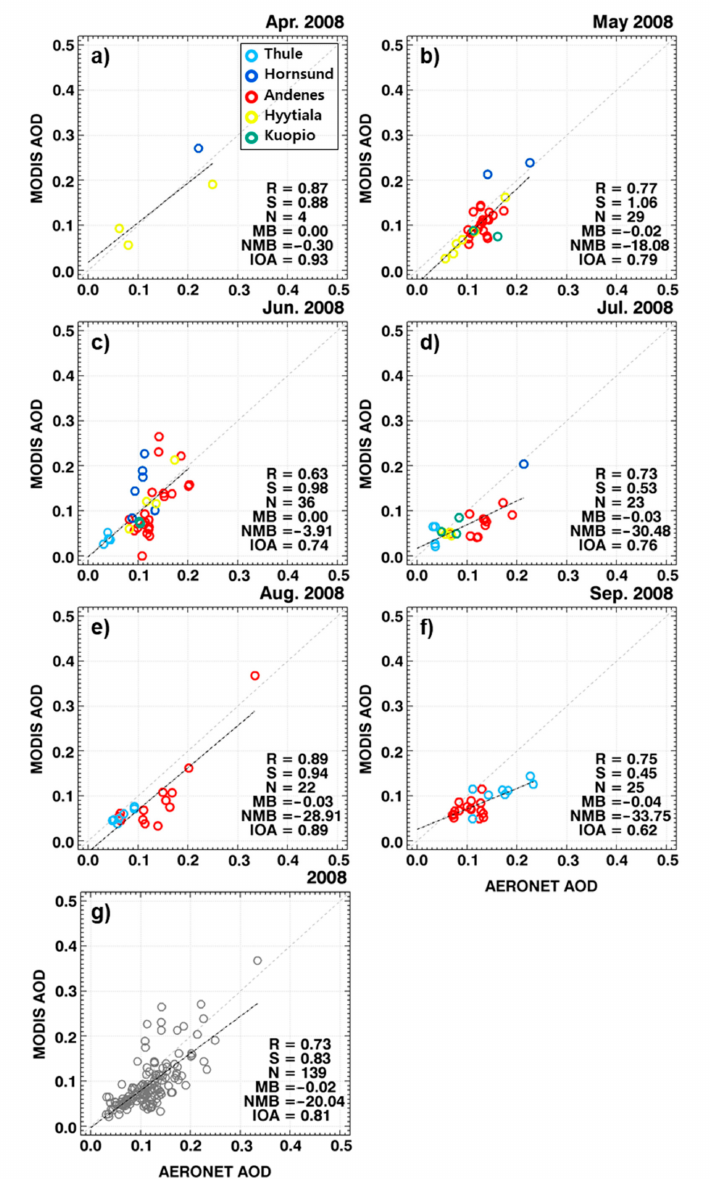
Figure 2. Scatter plots between hourly τ AERONET and τ MODIS for ( a ) April, ( b ) May, ( c ) June, ( d ) July, ( e ) August, ( f ) September, and ( g ) all months. Their statistical analysis of R (correlation coefficient), S (slope), N (number of data), MB (mean bias), NMB (normalized mean bias, %), and IOA (index of agreement) was